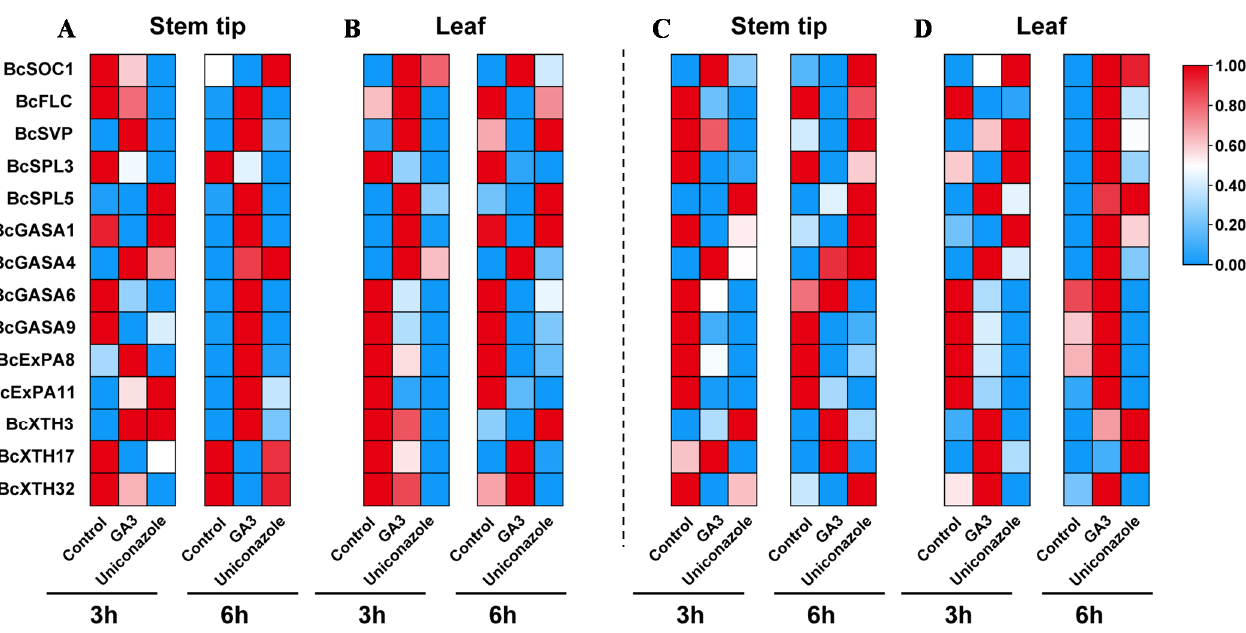
Figure 4. Expression profiles of flowering and elongation genes in flowering Chinese cabbage. ( A , B ): two-true-leaf treatment, ( C , D ): three-true-leaf treatment. Each column displays normalization independently. GA3, gibberellin A3.